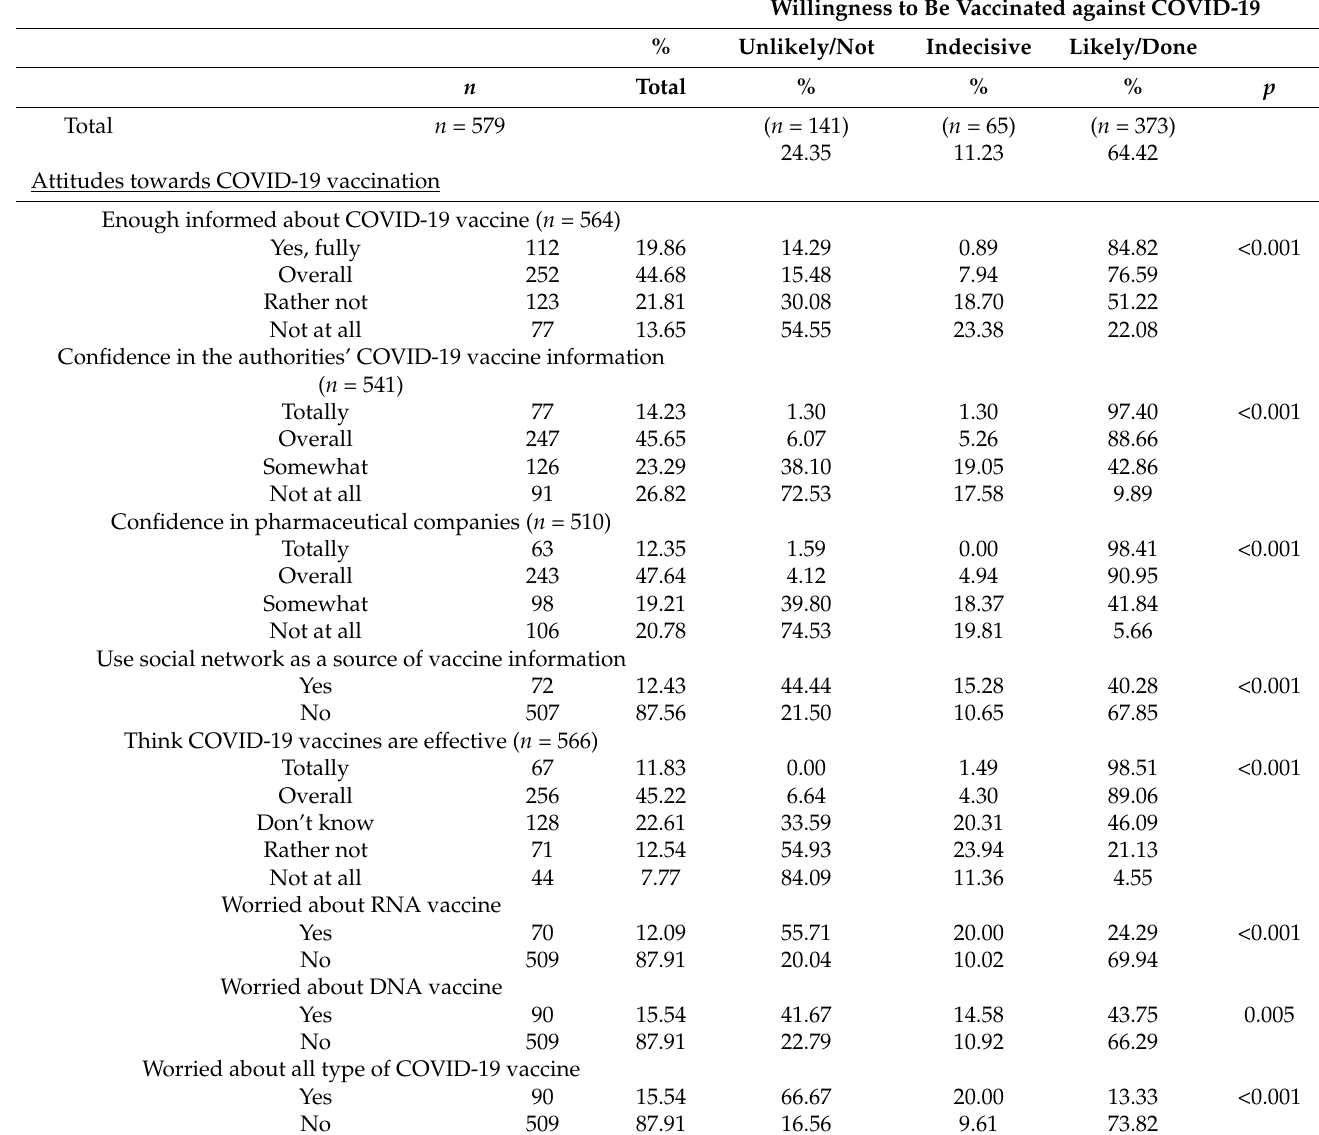
Table 5. Attitudes towards COVID-19 vaccination association with willingness to be vaccinated against COVID-19. Willingness to Be Vaccinated against COVID-19 % Unlikely/Not Indecisive